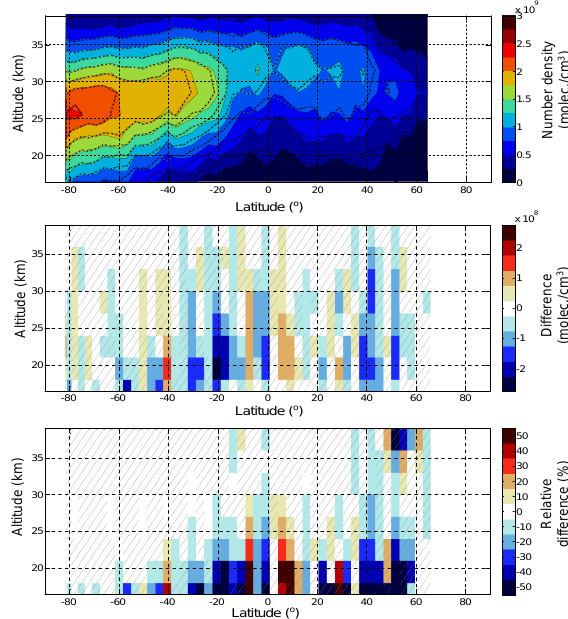
Fig. 4. Top panel: vertical and latitudinal distribution of NO 2 num- ber density for orbit 35499 on 14 December 2008 retrieved by the 2-D approach (color plot with solid contourlines) and 1-D approach (dashed contourlines). Middle and bottom panels: absolute and relative difference between 1-D and 2-D approach for the retrieval boxes. Boxes, where the retrieval error is larger than the difference, are shaded by a diagonal pattern.